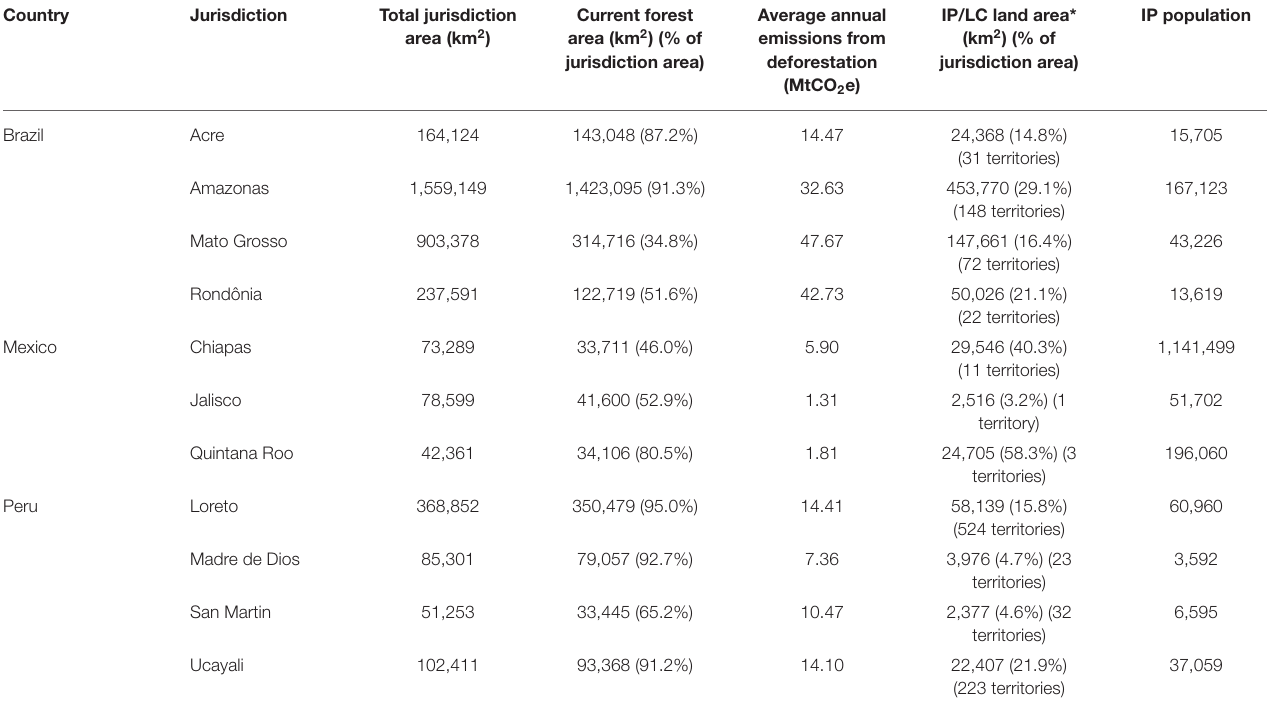
TABLE 2 | Study jurisdictions.